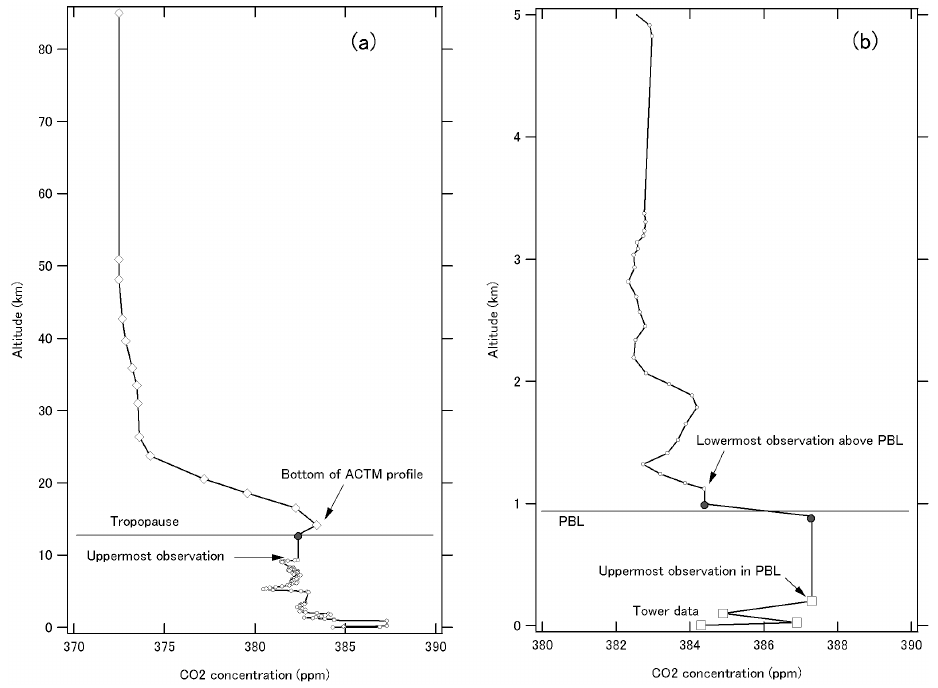
Fig. 3. Schematic example of a vertical CO 2 profile: (a) the profile from the ground to 85km; (b) an expanded view of the profile between the ground and 5km. Open circles, squares, and diamonds show data observed by aircraft, data observed by towers, and the ACTM profile, respectively. Closed circles show the assumed value at the tropopause and the top of the PBL.